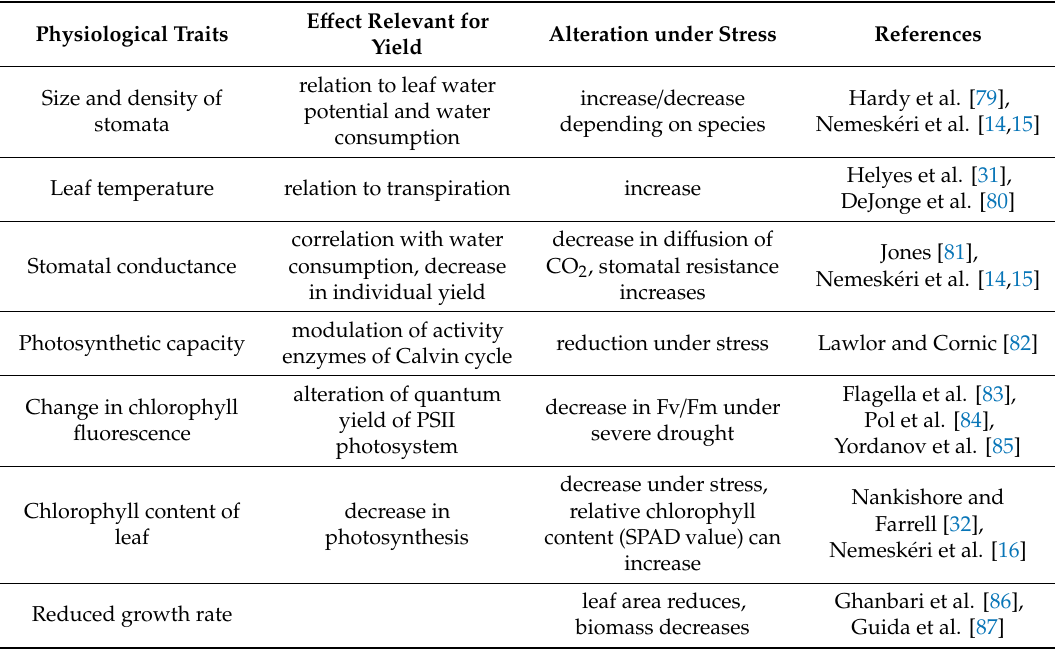
Table 1. Physiological traits relevant for response to